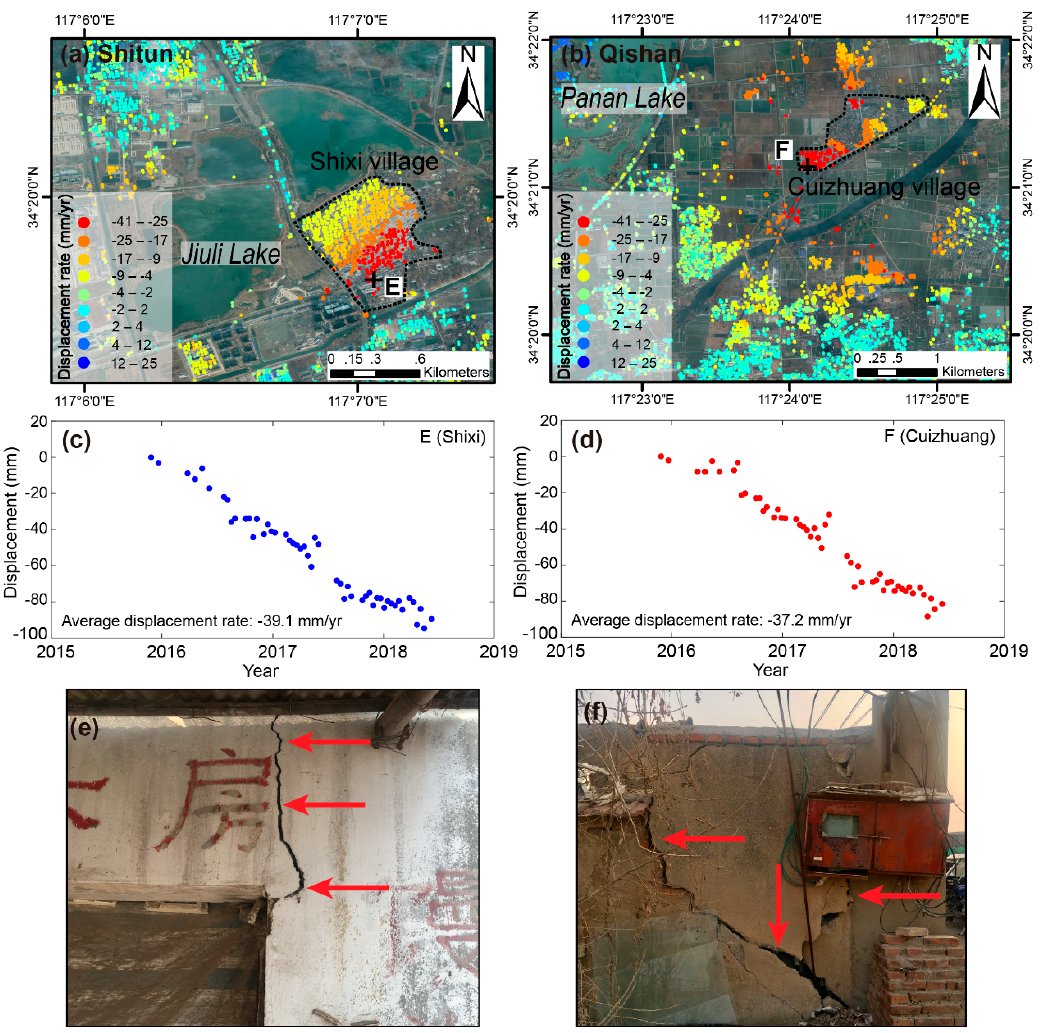
Figure 10. ( a ) Enlarged map of displacement rate (2015–2018) around Shitun mine (the western white rectangle in Figure 6). The village of Shixi is outlined by dashed black lines. The map conventions are the same as in Figure 4. ( b ) Enlarged map of displacement rate (2015–2018) around Qishan mine (the eastern white rectangle in Figure 6). The village of Cuizhuang is outlined by dashed black lines. The map conventions are the same as in Figure 4. ( c ) and ( d ) Displacement time series and displacement rates of points E and F marked by black crosses in ( a ) and ( b ), respectively. ( e ) and ( f ) Damages to local houses caused by land subsidence.